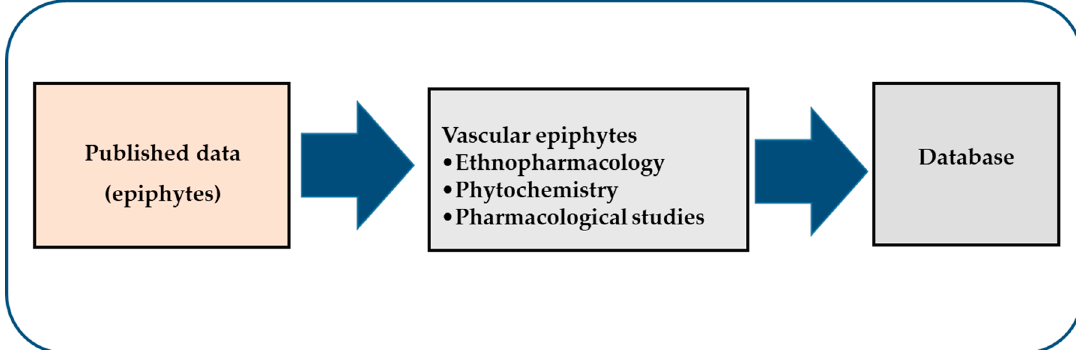
Figure 1. Schematic data collection approach.